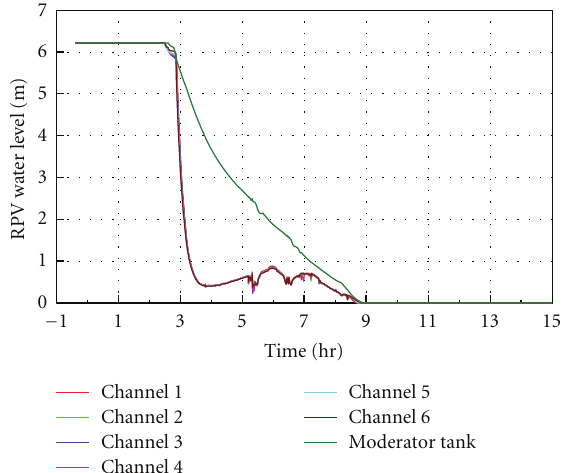
Figure 18: Water level in coolant channel rings 1 to 6 and mode- rator tank.